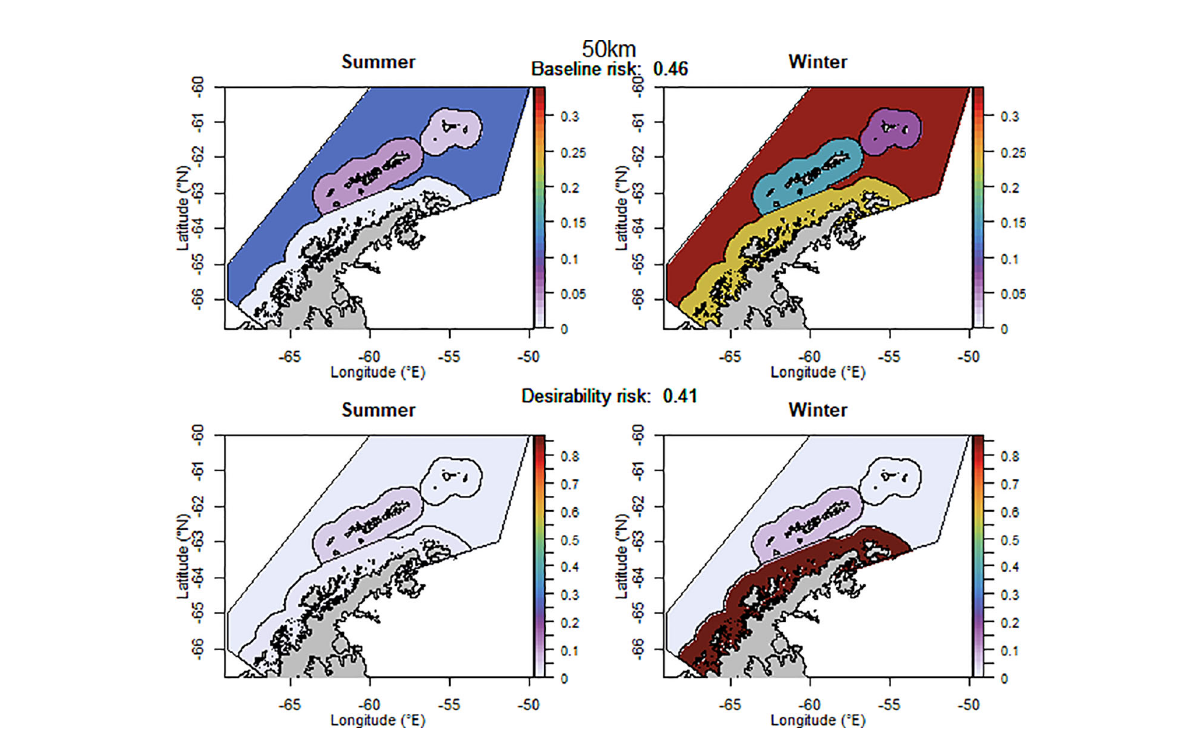
FIGURE 5 The proportion of the annual krill catch limit that could be taken from each management unit (delineated using the 50 km buffer from land) during summer and winter when the risk assessment was implemented after the winter krill layer was adjusted. Values sum to 1 across all management units and both seasons for each of the baseline (upper panel) and desirability (lower panel)